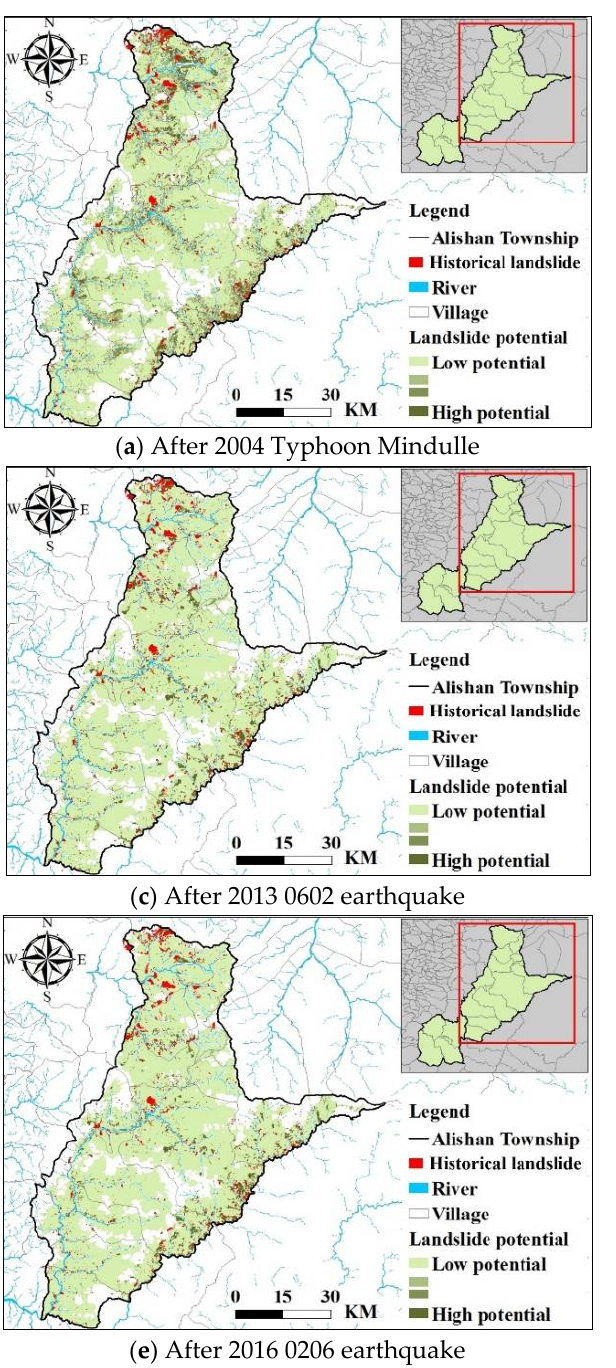
Figure 10. Landslide potential map of Alishan Township after rainfall and earthquakes overlapped by historical landslides.